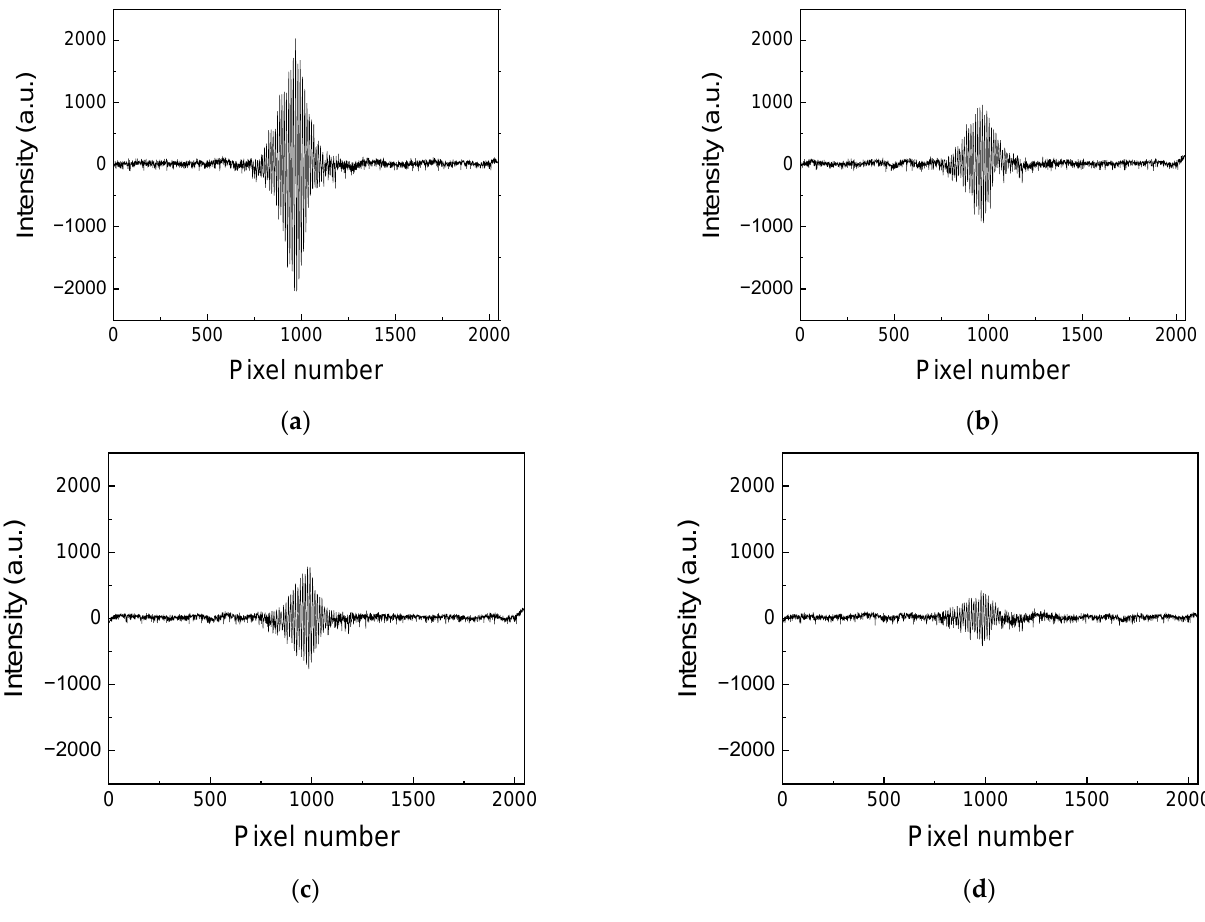
Figure 4. The interferograms with the pulse width of the pumping laser. ( a ) The initial interferogram when the solid-state dye is irradiated by 2.5 ms pulse width of the laser. ( b ) The interferogram when the solid dye is irradiated for 900 s by 2.5 ms pulse width of the laser. ( c ) The interferogram when the solid dye is irradiated for 900 s by 5 ms pulse width of the laser. ( d ) The interferogram when the solid dye is irradiated for 900 s by 10 ms pulse width of the laser.